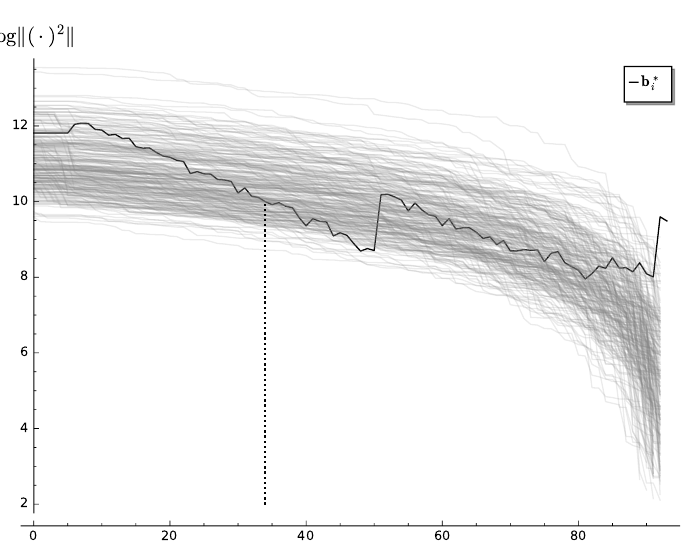
Figure 4: Projected lengths for 256 samples of (∆ ( ‘ ) , θs ) and the norms of the Gram- Schmidt vectors for our reduced basis B 0 for θ = 3 with κ = 19, folded down three times to n = 32 and shaved with parameters α, β = 4 , 2. The dotted line indicates d − bs , i.e. where we start